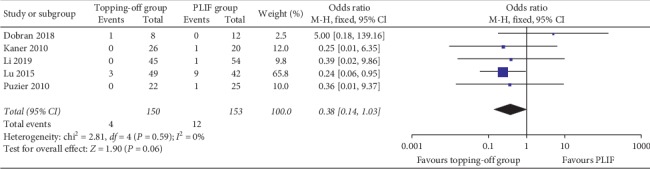
Forest plot of CASD.